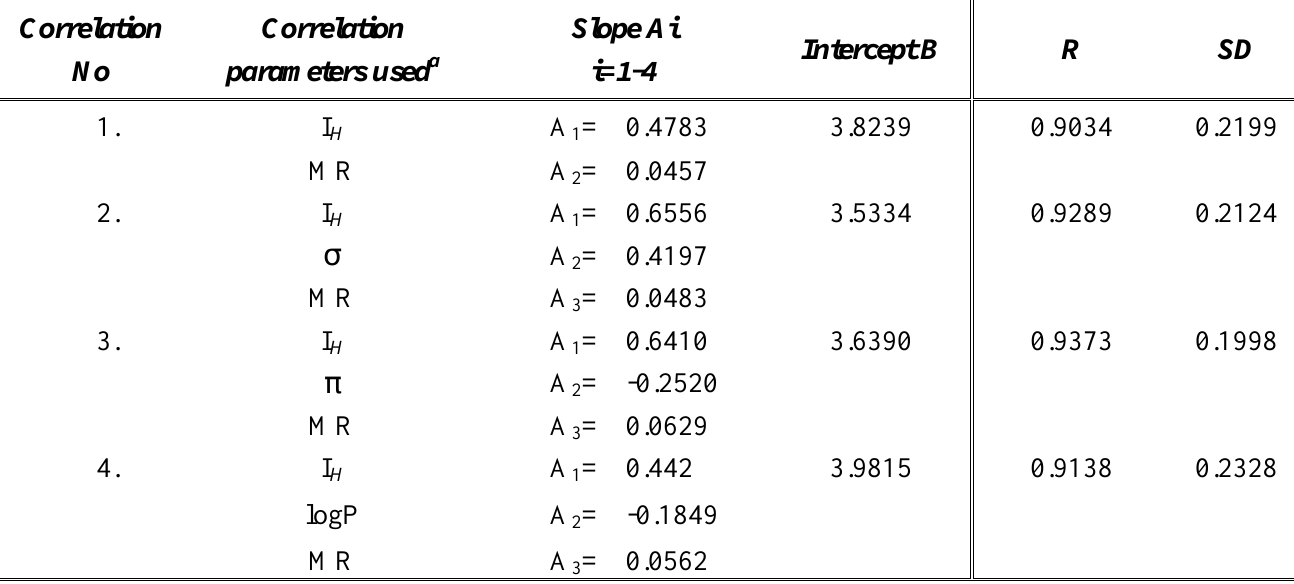
Table 6. Regression parameters and the quality of correlation of log 1/C with s,